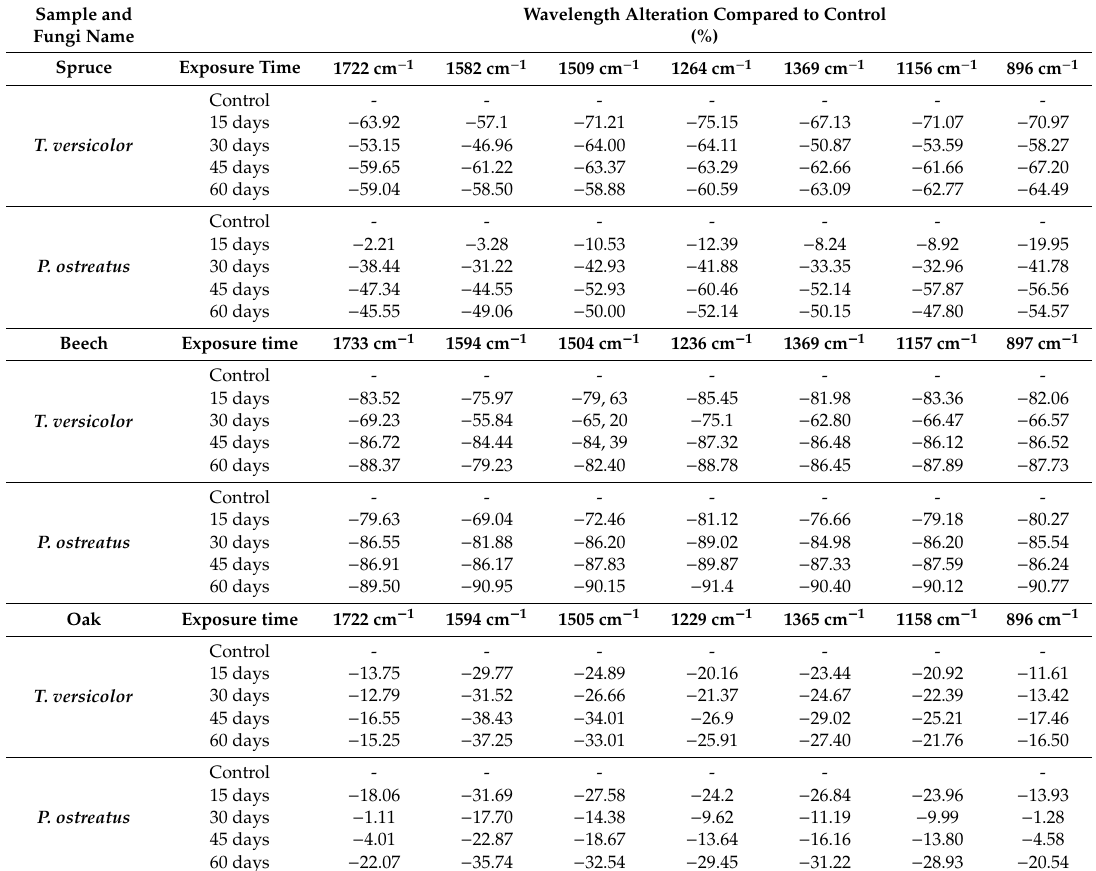
Table 2. Alteration of absorbance in representative